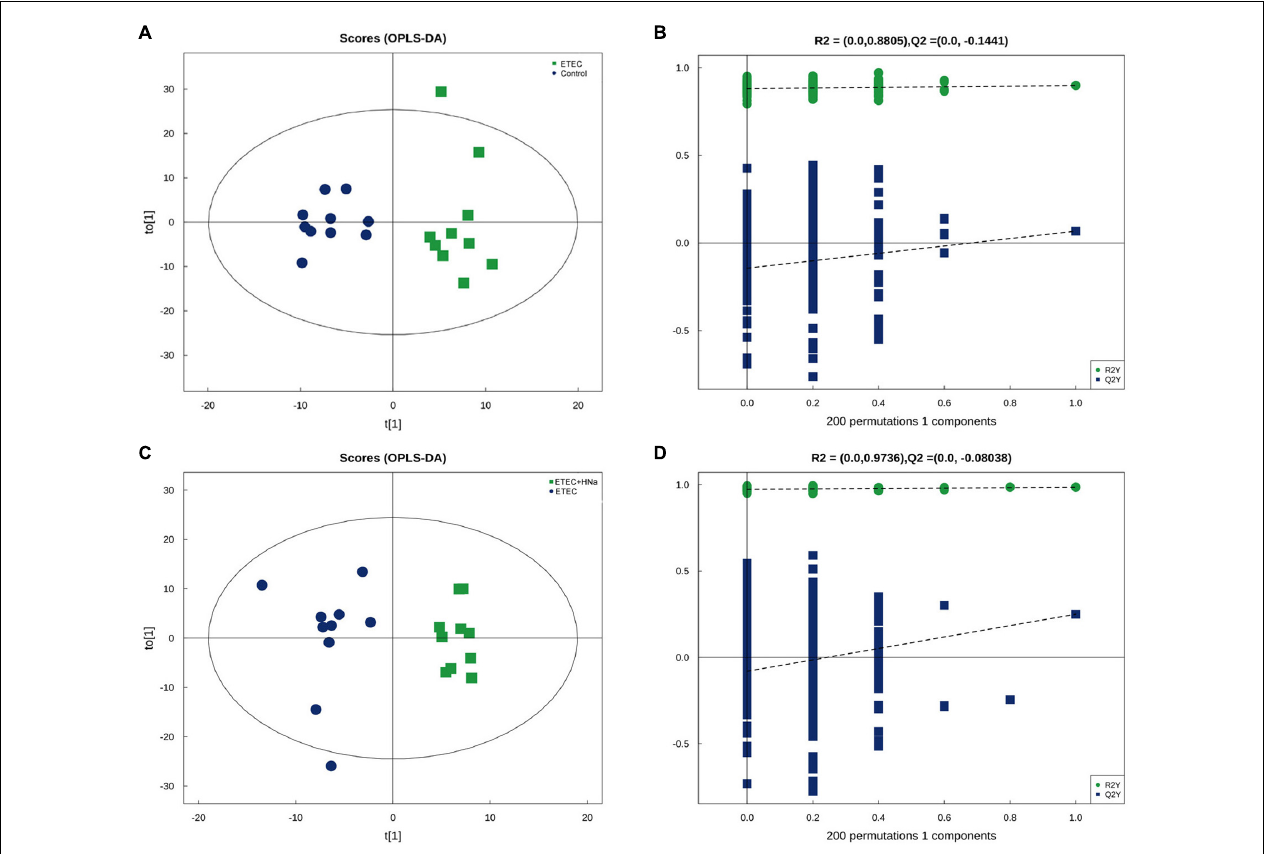
FIGURE 7 | Differentiation of the metabolic profiles using multivariate analysis. Orthotopic partial least-squares discriminant analysis (OPLS-DA) score plots from control vs ETEC (A,B) and ETEC vs ETEC + HNa (C,D) of fecal metabolites under negative ion mode. R2 and Q2 represent the interpretability and predictability of models. Enriched Kyoto Encyclopedia of Genes and Genomes (KEGG) pathway enrichment based on altered metabolites. The color of the point was P -value, and the redder, the more significant enrichment. The size of the spot represented the number of different metabolites enriched. Control vs ETEC group (E) ; ETEC + HNa vs ETEC group (F)